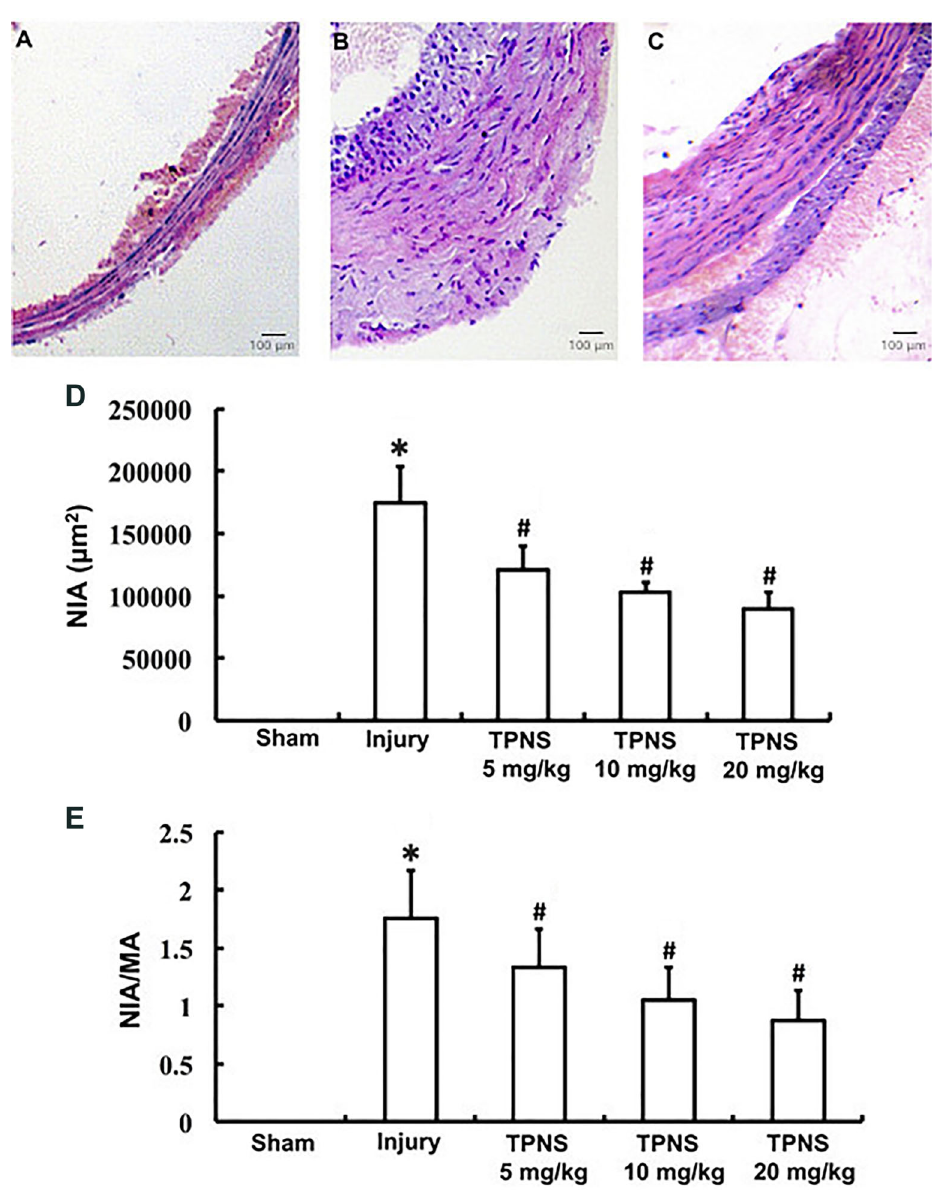
Figure 1. Effect of total Panax notoginseng saponin (TPNS) on neointimal hyperplasia induced by balloon-injury. A , B , and C demonstrate neointimal hyperplasia sections (H&E 100 (cid:1) , bar: 100 m m) in the sham group, injury group, and high dose (20 mg (cid:3) kg – 1 (cid:3) day – 1 ) TPNS-treatment group, respectively. D and E, data obtained from the Image-Pro Plus analysis system showing mean values of neointimal area (NIA) and NIA/media area (MA) ratio, respectively, after intervention in the sham group, injury group, and low, medium, and high dose TPNS-treatment groups (5, 10, and 20 mg (cid:3) kg – 1 (cid:3) day – 1 ). Data are reported as means ± SE of 10 rats per group. *P o 0.05 compared to Sham; # P o 0.05 compared to injury (ANOVA and Tukey ’ s HSD post hoc